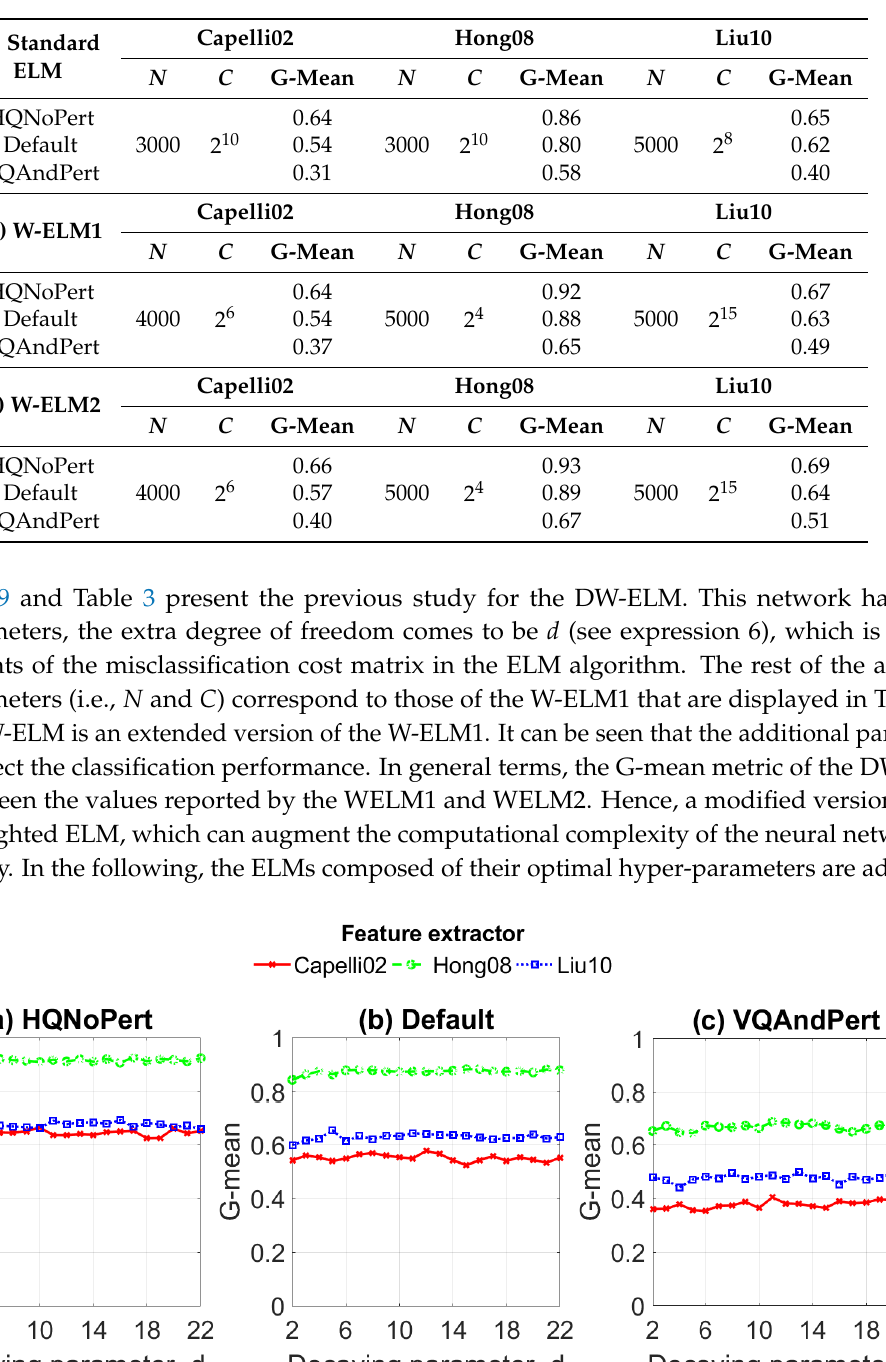
Table 2. Results of the G-means metric obtained by ( a ) Standard ELM, ( b ) W-ELM1, and ( c ) W-ELM2 on the testing sets for the combination of optimal hyper-parameters ( N and C ). All datasets and feature extractors are considered.